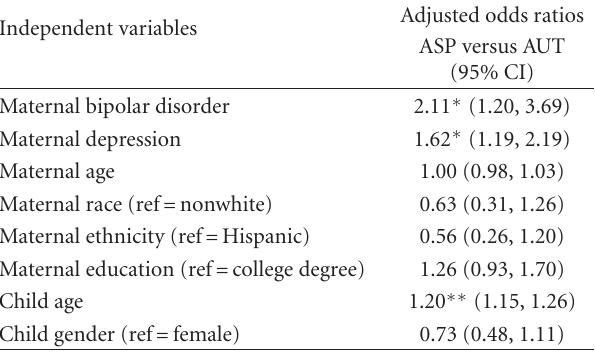
Table 3: Multivariate logistic regression analysis of Asperger syndrome (ASP) versus autistic disorder (AUT) phenotype among children with ASD by presence of professionally diagnosed maternal mood disorder ( n = 998 mother-child dyads).